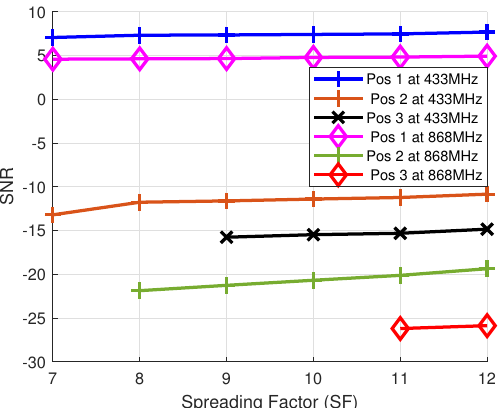
Figure 16. SNR vs. SF with CR = 4/5, BW = 125 KHz for POS 1–POS